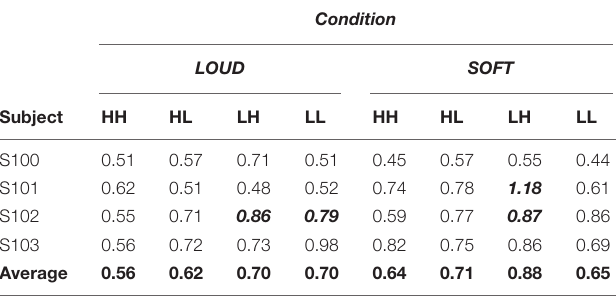
TABLE 4 | Mean capacity values for the different conditions tested.